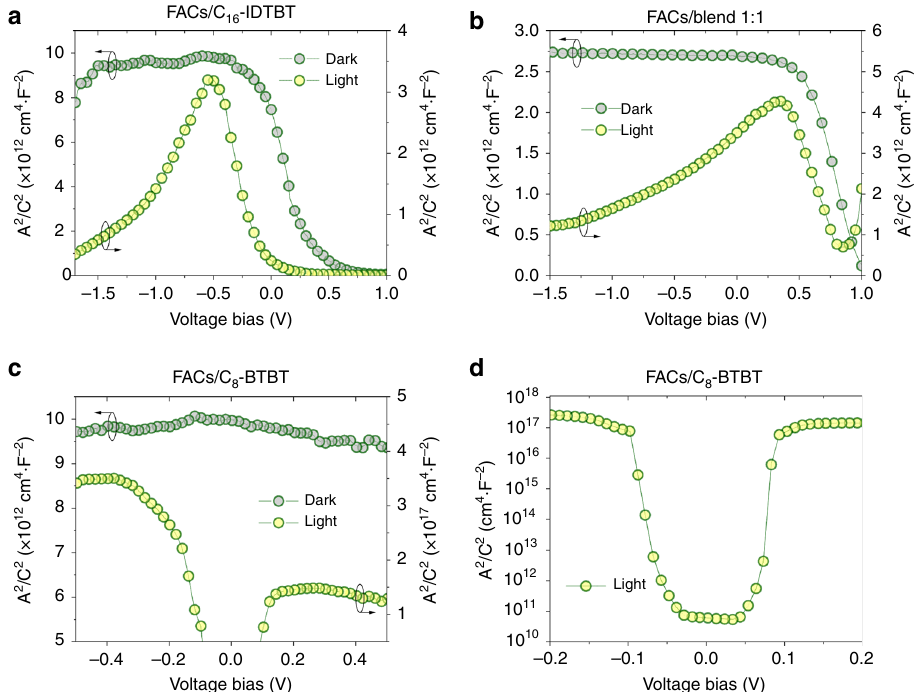
Fig. 4 Mott-Schottky analysis for FACs/OSC bilayers. a – d Mott-Schottky plots for different FACs/OSC bilayer stacks: a FACs/C 16 -IDTBT; b FACs/blend 1:1; c FACs/C 8 -BTBT; d shows the detailed changes for the voltage bias between − 0.2 and 0.2 V in ( c ). In ( a ) – ( d ), C/A is geometric capacitance (F cm − 2 ) where C and A stand for capacitance (F) and area (cm 2 ), respectively. The impedance spectroscopy measurements were carried out with an AC perturbation of 10 mV at 5 kHz in the dark (grey- fi lled dark green circles) as well as under a white-light LED illumination source (~2.61mW cm − 2 ; data shown in yellow- fi lled bright green